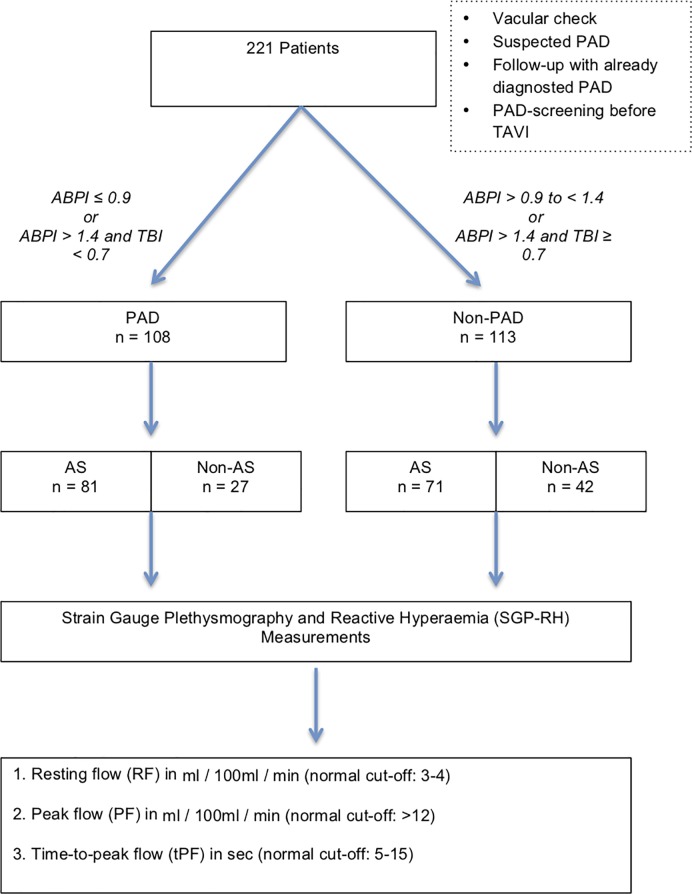
Study flow chart.